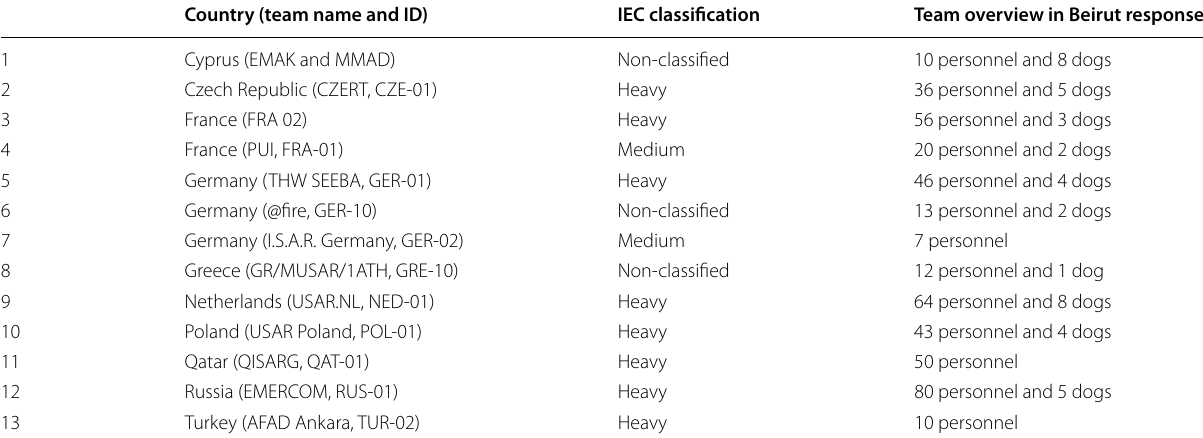
Table 2 List of international USAR teams deployed to Beirut. Created by the authors based on INSARAG (2020b). “IEC classification” means the classification level when the teams went through the IEC process and does not mean the level for the Beirut deployment. The details of each team can be found at the USAR Directory on the INSARAG website (https:// www. insar ag. org/ direc tory/ usar- direc